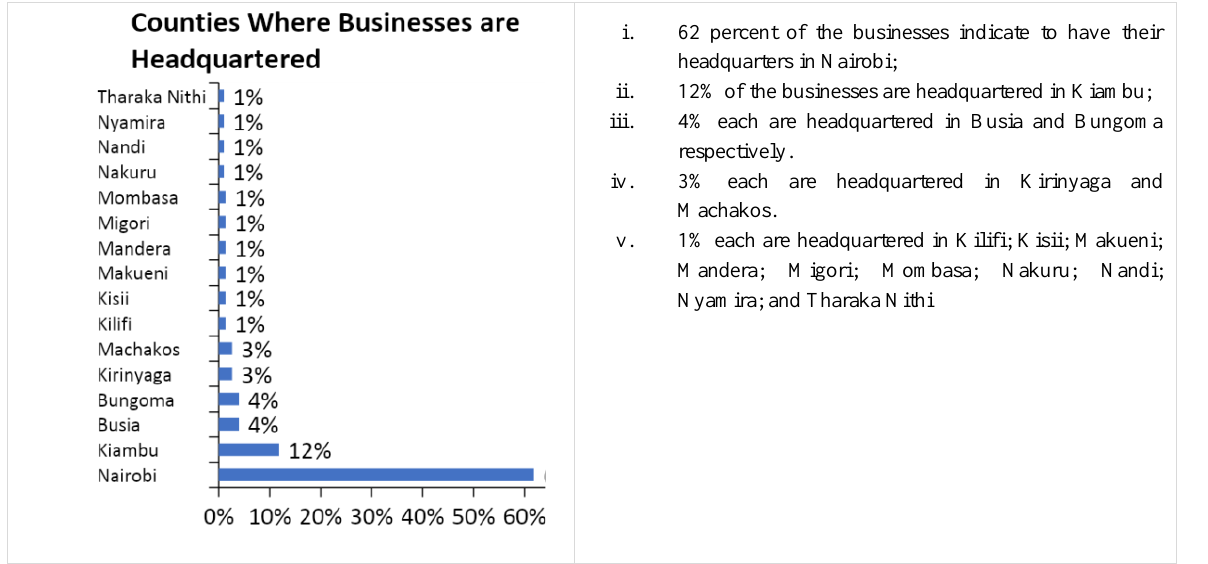
Figure 14: Location of